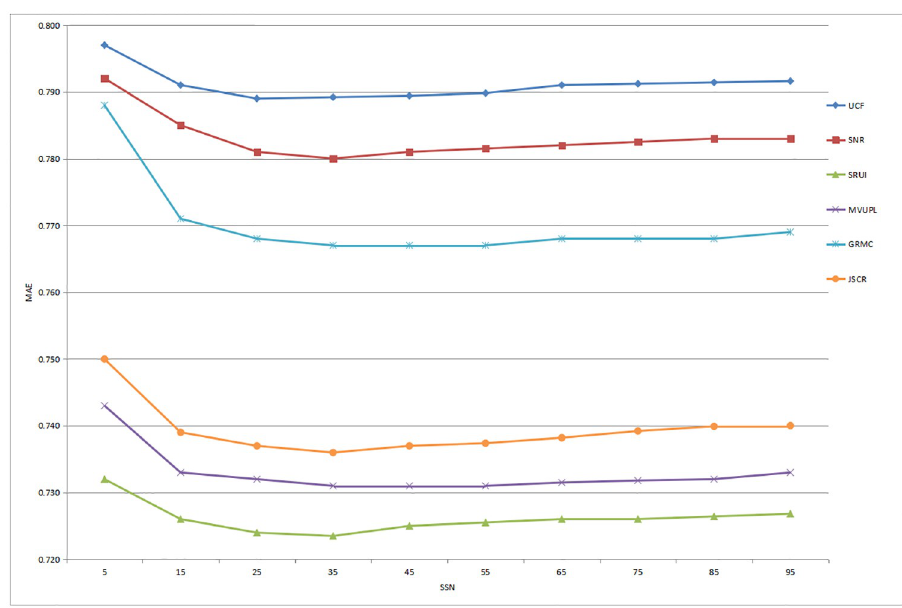
Fig 5. Prediction accuracy of all the comparison methods for different numbers of social similar neighbors based on the Epinions dataset